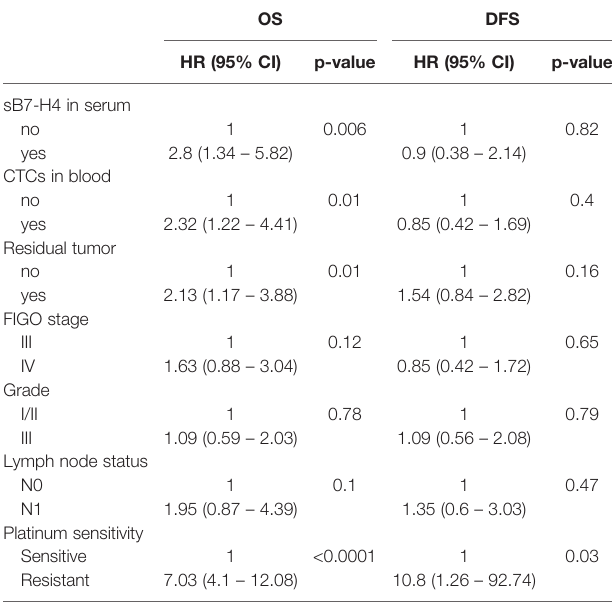
TABLE 3 | Results of univariate Cox regression analysis of patients with advanced EOC.